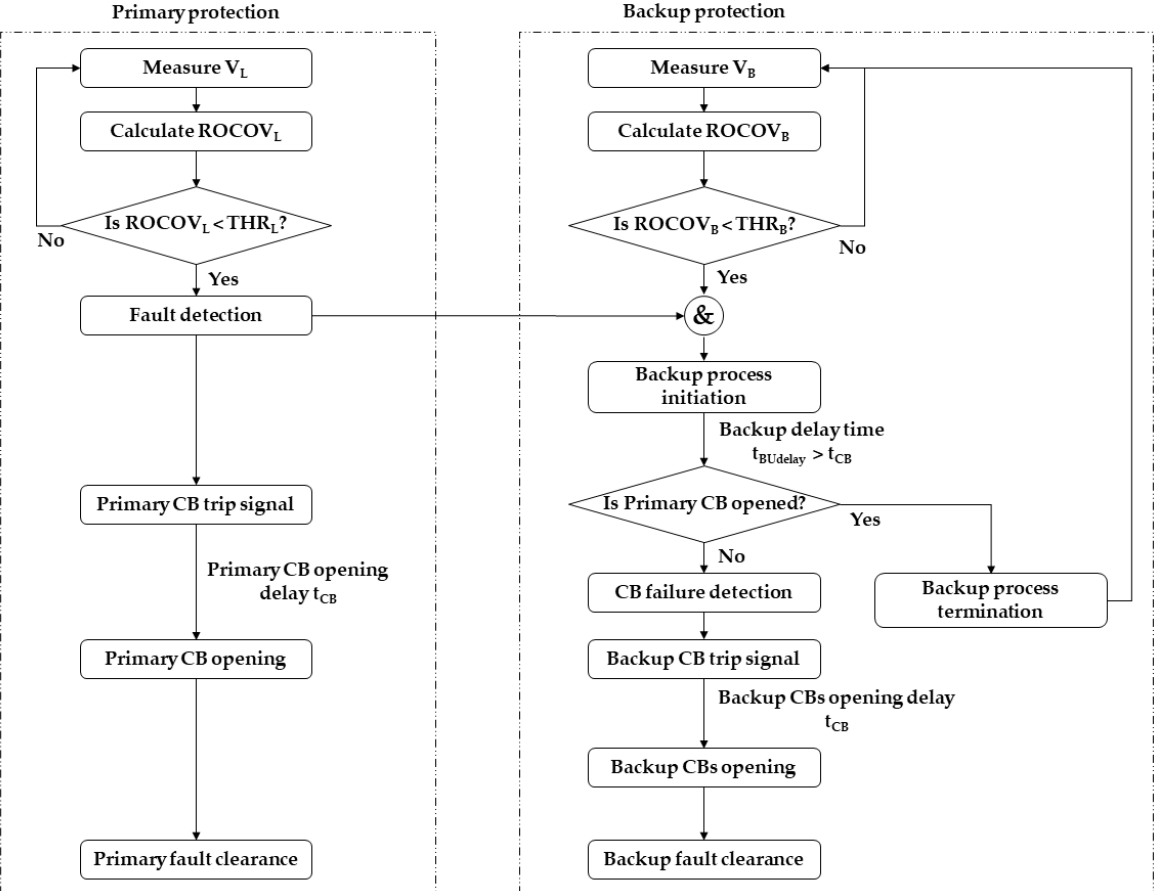
Figure 6. Flow chart of the proposed protection system.